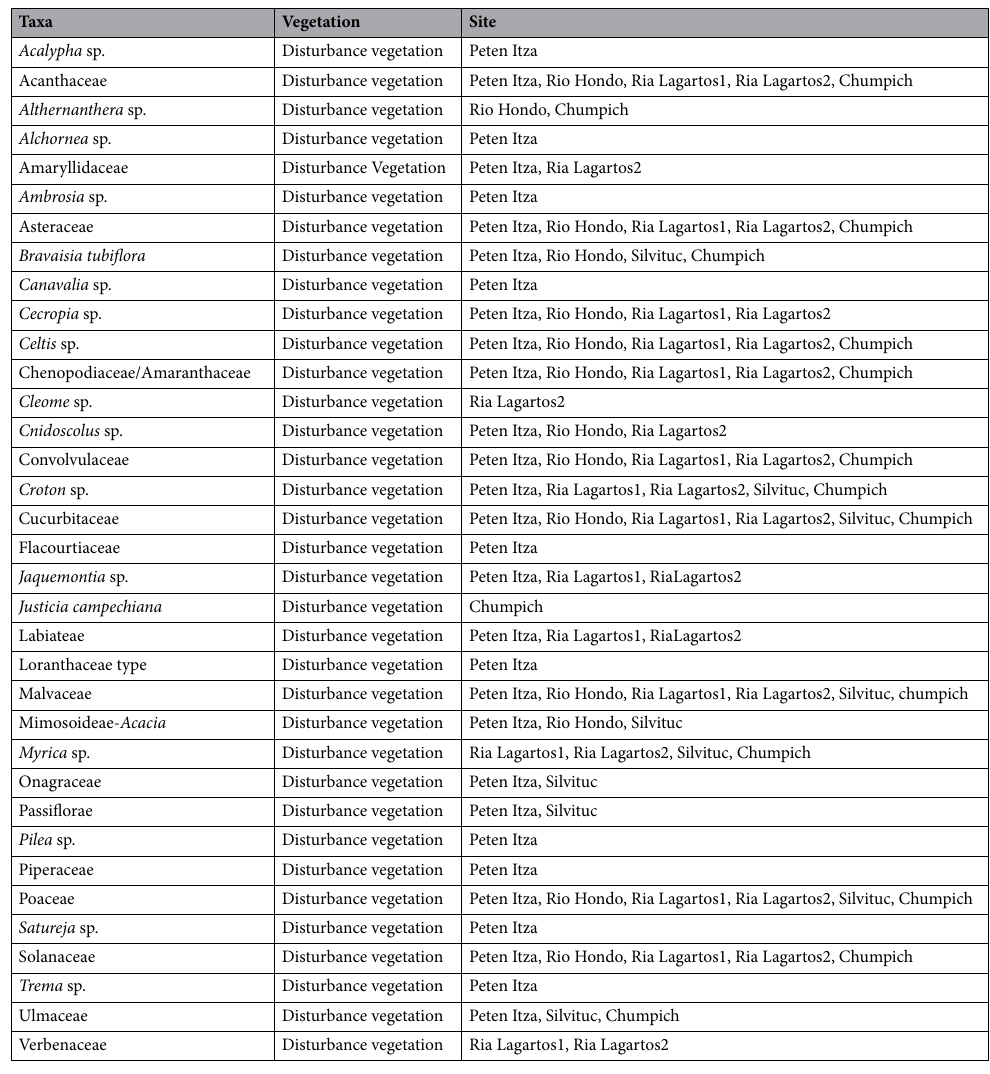
Table 2. Taxa from the six pollen